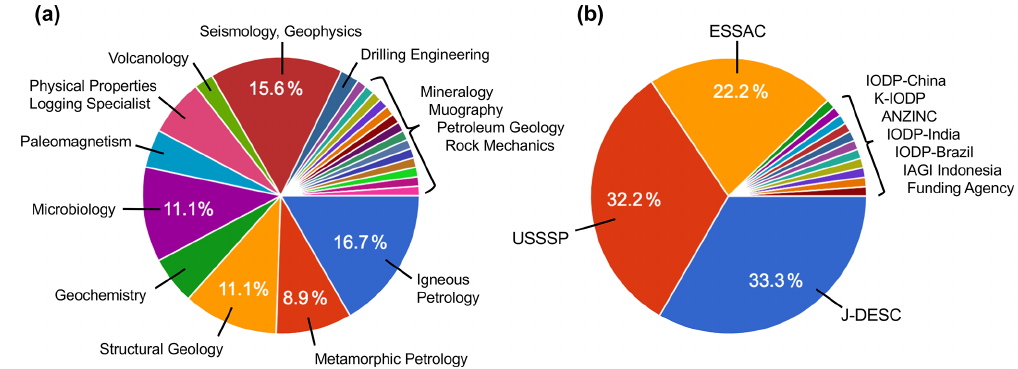
Figure 2. Statistics of the workshop participants. (a) Expertise of participants. (b) Locations of participants (based on the IODP Project Management Office and other information). The total number of registered participants was 106 from 16